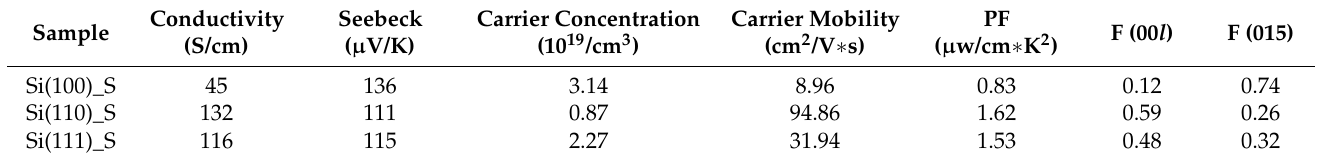
Table 1. Room temperature thermoelectric properties and orientation factors of Si(100)_S, Si(110)_S, and Si(111)_S thin